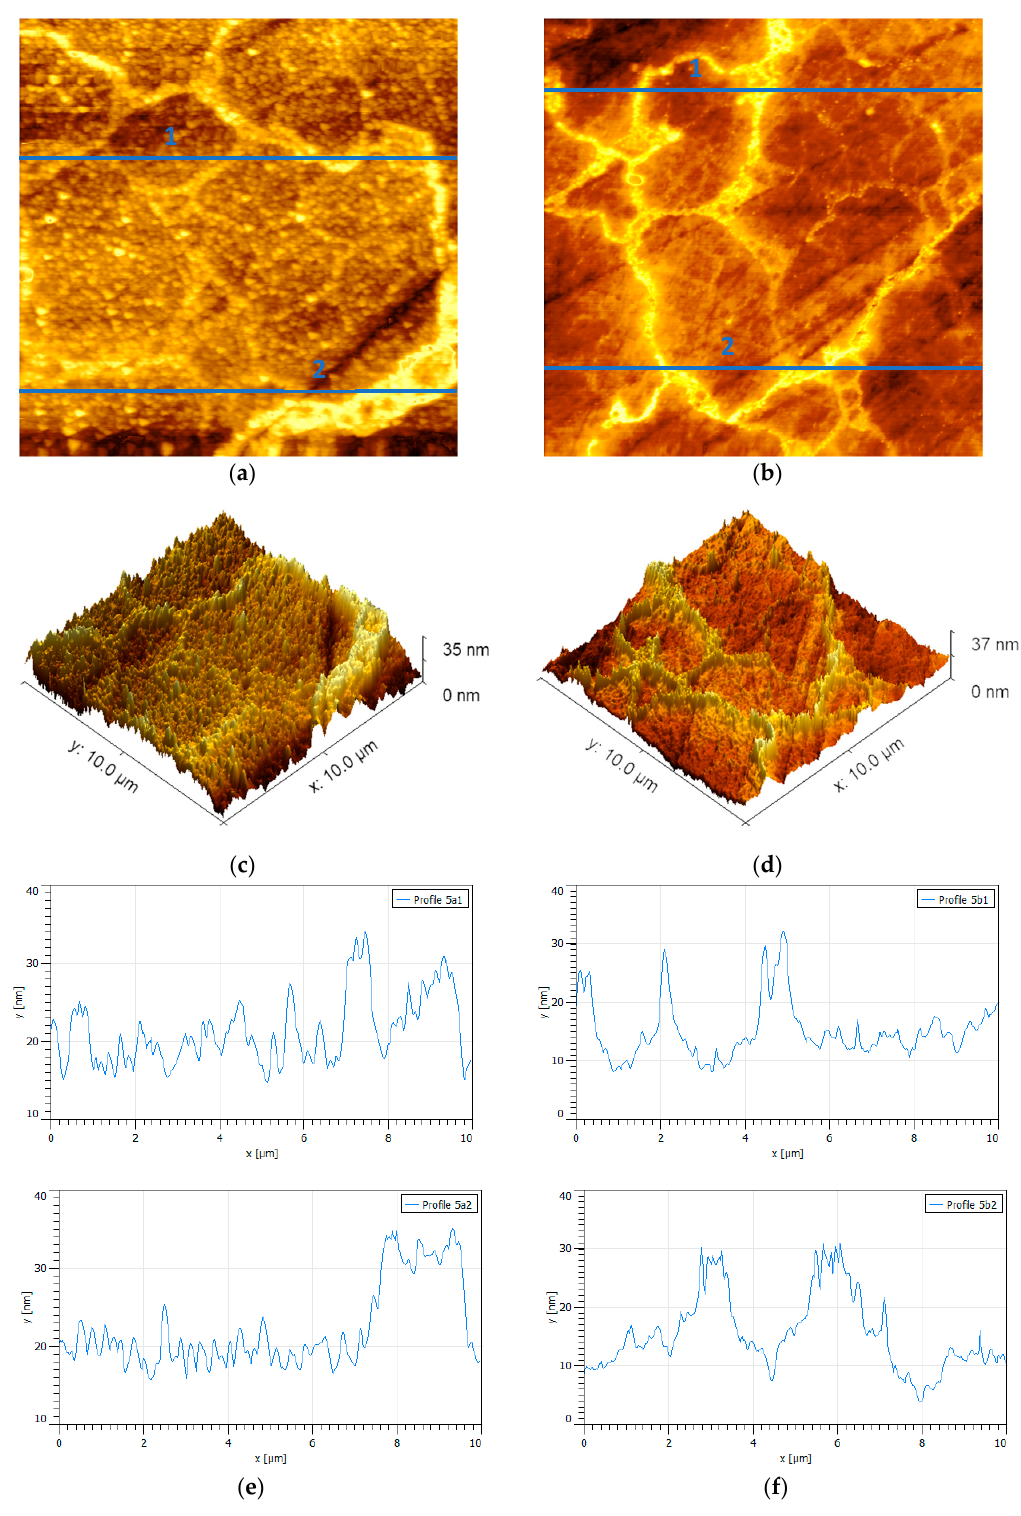
Figure 4. Surface {100} of oxidized pyrite exposed to PAX 10 − 3 [M] at pH 8.5 ( a – b ). Scan size is 10 × 10 μ m 2 . ( c – d ) Topographic maps of images ( a ) and ( b ), respectively. ( e – f ) Height profiles corresponding to blue lines 1 and 2 in ( a ) and ( b ), respectively; the highest peaks correspond to pillars.